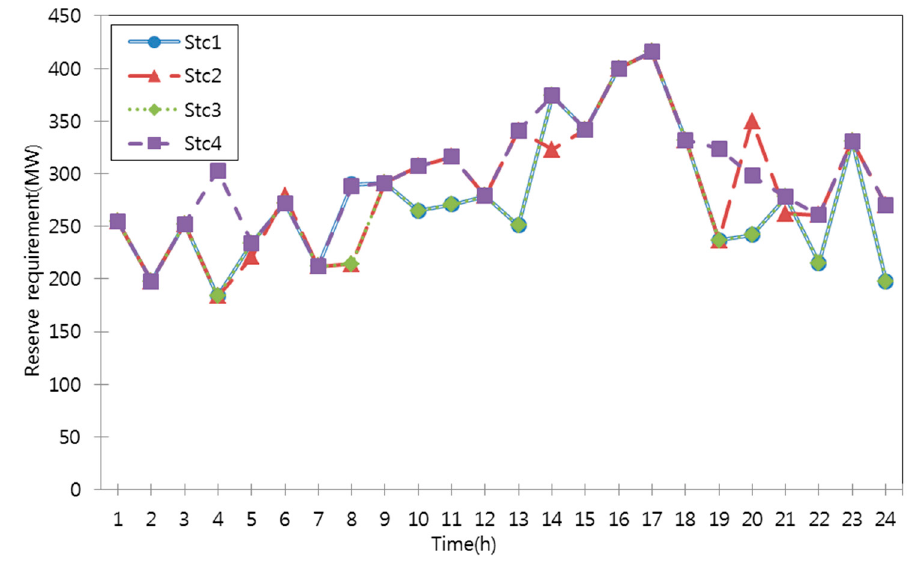
Figure 7. Reserve requirement with the UIM.